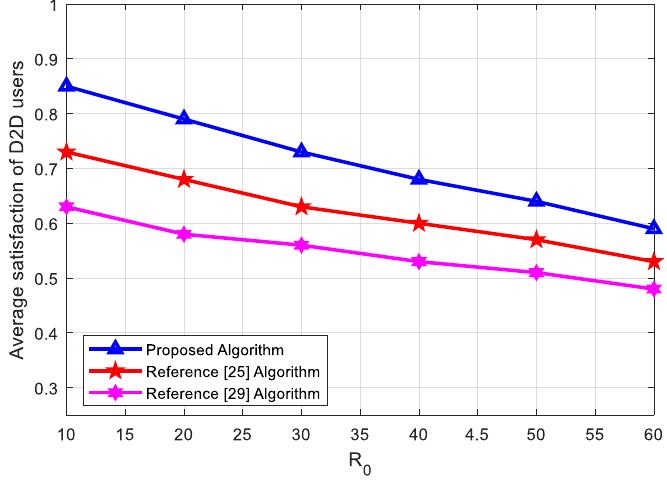
Figure 7. Comparison of the average satisfaction of D2D users under different values of 𝑅 0 with 𝑁 = 20 .